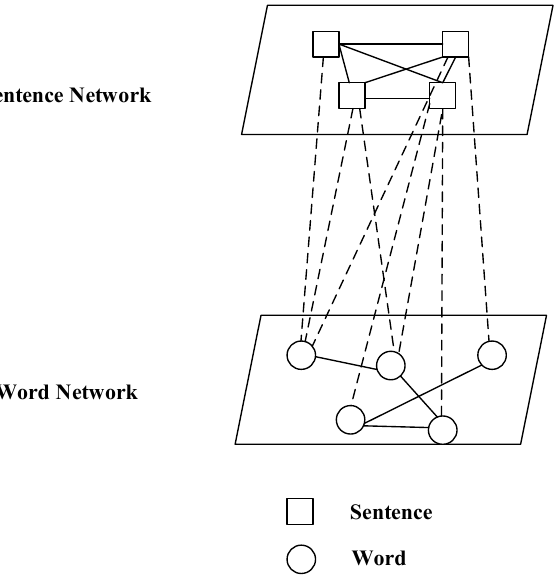
Figure 1. The structure of the new word sentence (NWS) method.